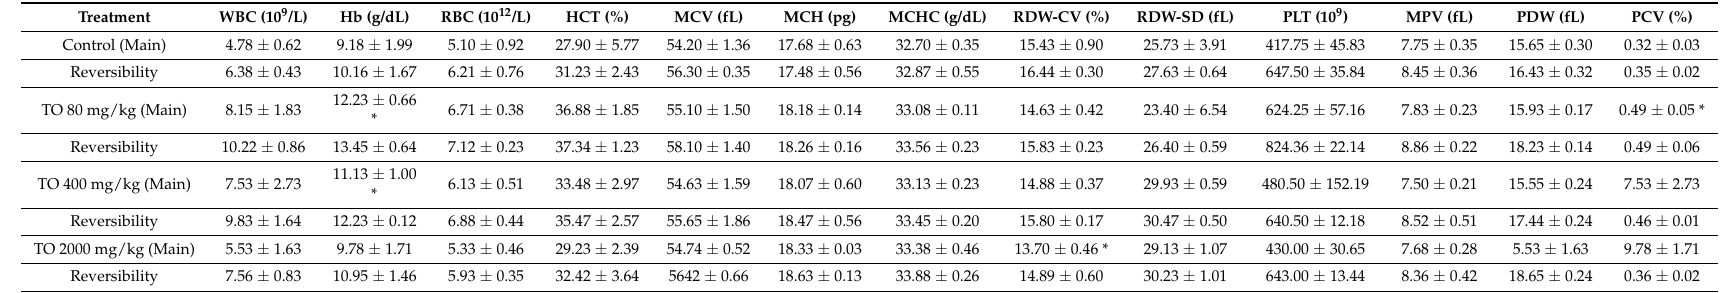
Table 3. Effect of T. occidentalis on hematological